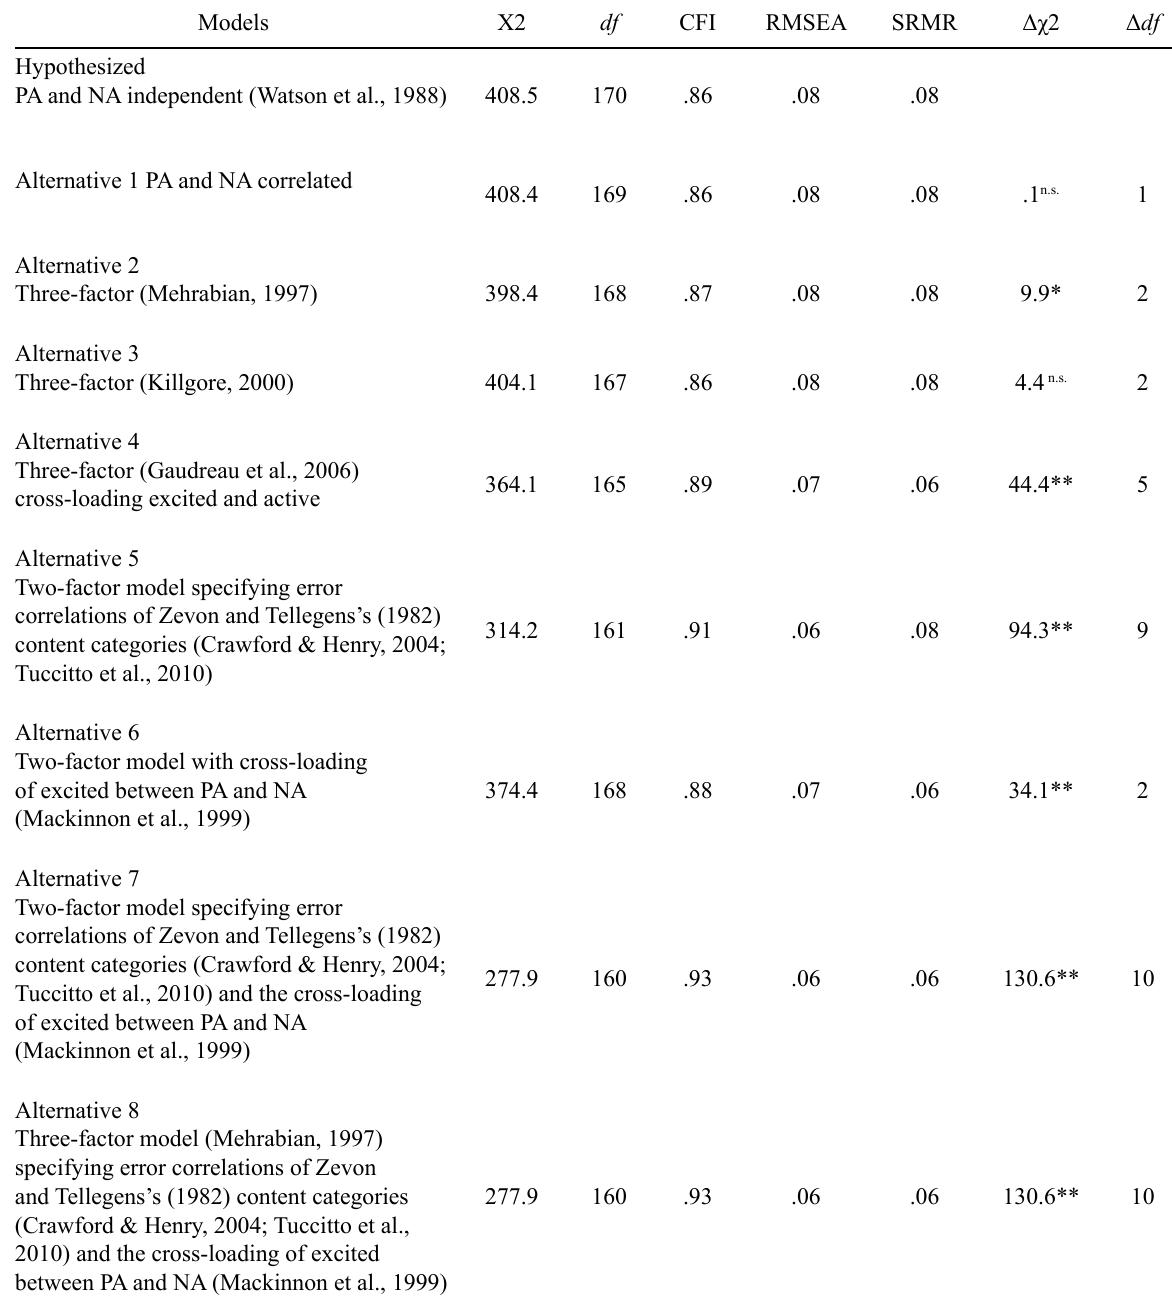
Table 1 Comparison of the Goodness-Of-Fit Indices for the Hypothesized and the Alternative Models for the Structure of the PANAS